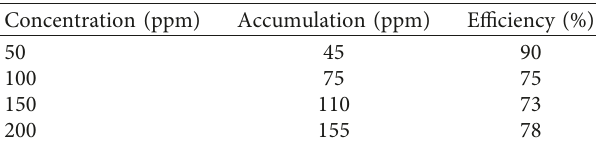
Table 4: Accumulation of Cu 2+ by orange